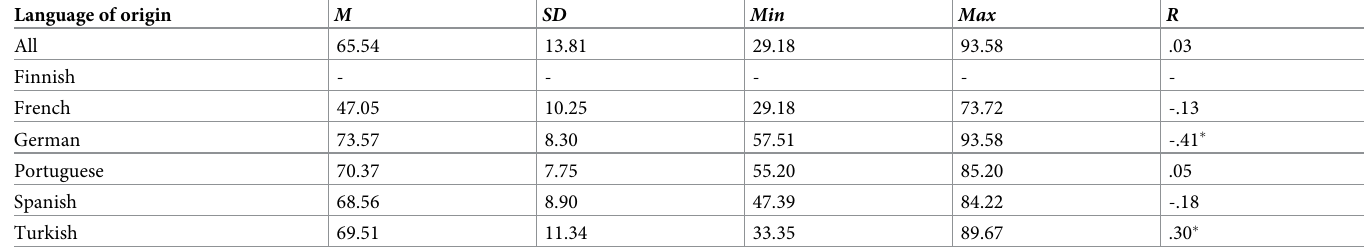
Table 9. Means, standard deviations, and minimum and maximum values of the Flesch Reading Ease scores for the original texts and their correlations to the com- prehensibility rating. Language of